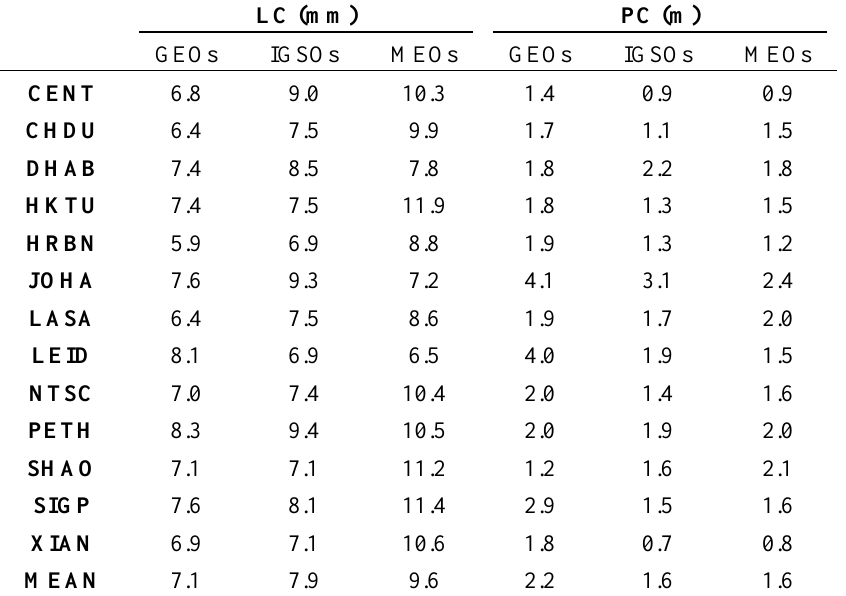
Table 4. Averaged RMS of the ionosphere-free phase (LC) and range (PC) observation residuals for each station-satellite pair.